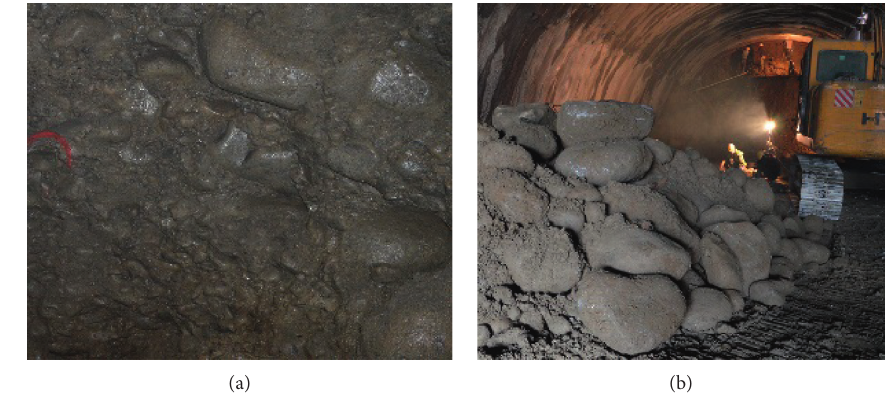
Figure 3: Boulder-cobble mixed on excavation face. (a) Details of the compact layers. (b) Boulder removed from excavation face. Ø 25 self-propelled hollow grouting bolt L = 3.5m